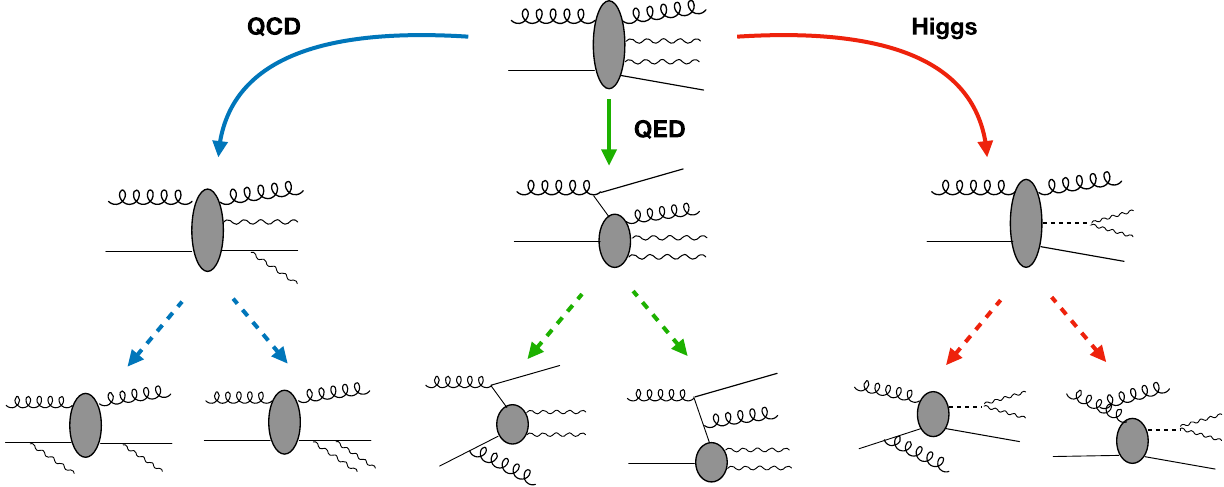
Fig. 1 Pictorial representation of the paths contributing to the calculation of the probabilities P ( { p i }| Higgs ) , P ( { p i }| QED ) and P ( { p i }| QCD ) , as described in the